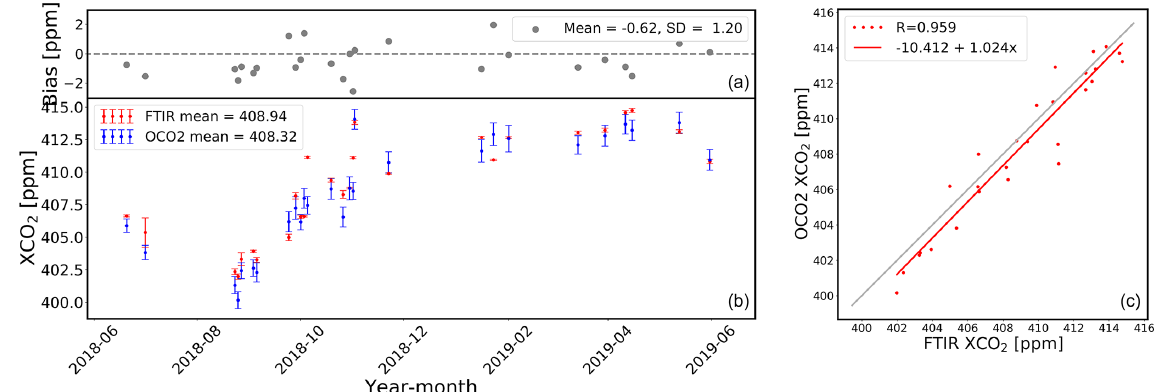
Figure 13. (a, b) Time series of daily mean co-located OCO-2 and ground-based FTIR XCO 2 data at Xianghe (b) and the bias between them (a) . The error bars are the daily SDs of co-located OCO-2 and the FTIR instrument XCO 2 data. (c) Correlation plot between co-located daily mean XCO 2 data from OCO-2 and the FTIR instrument at